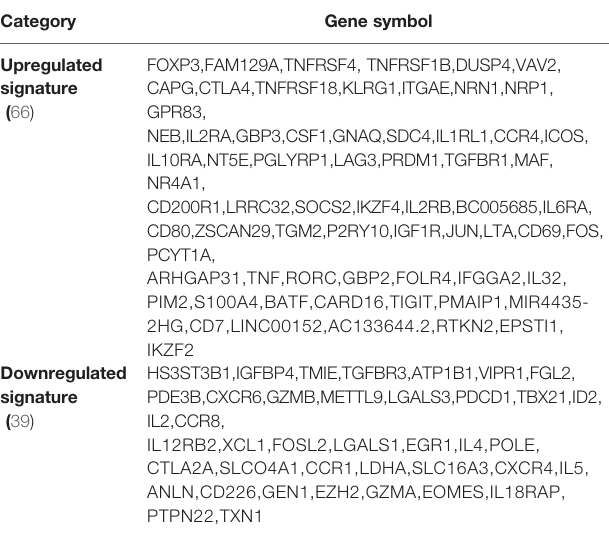
TABLE 4 | Based on all gene sets analyzed above, we generated a list of Treg signature genes including 68 upregulated and 40 downregulated genes in Figure 4